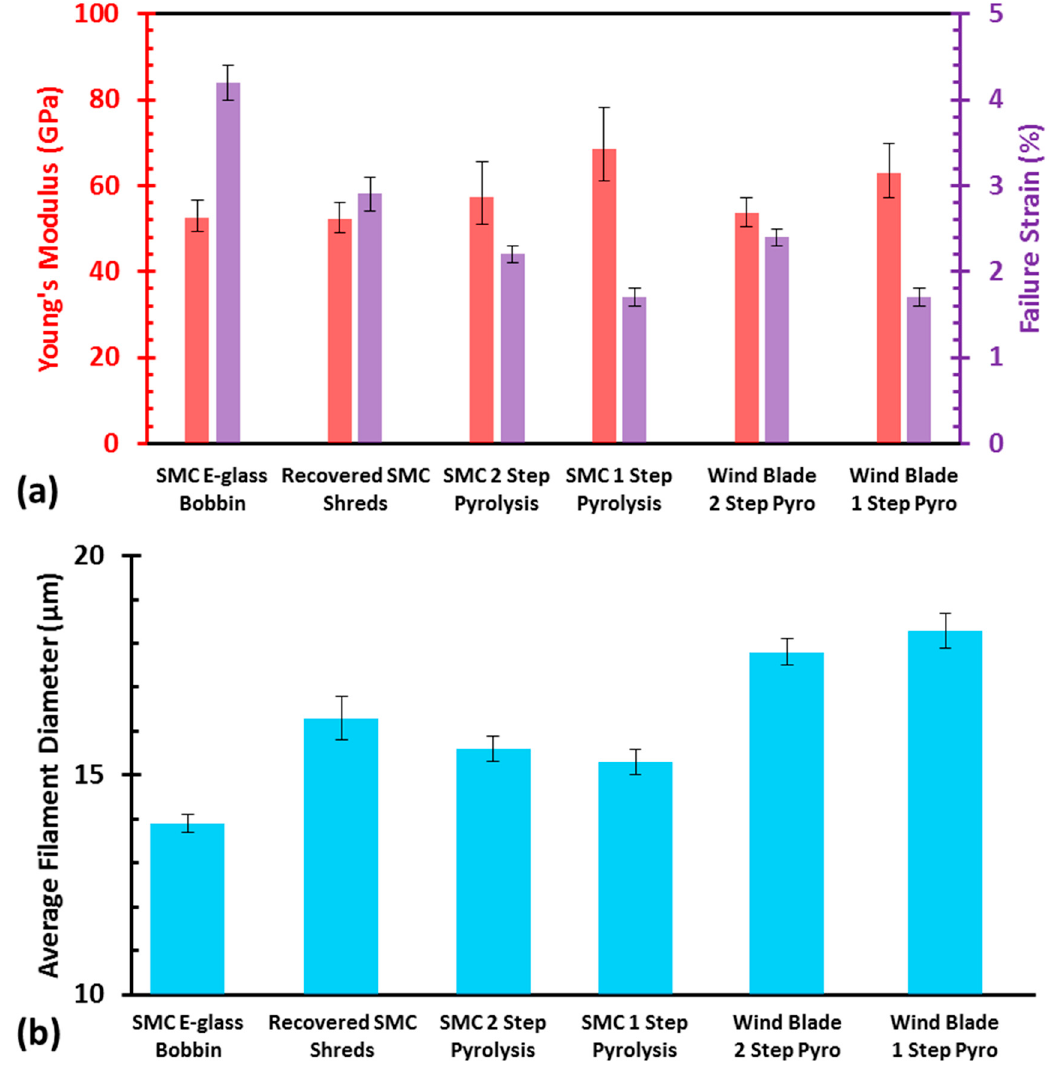
Figure 5. Average individual filament data ± standard error: ( a ) left / red columns representing Young’s modulus and right / purple columns representing failure strain for each tested condition, ( b ) average individual filament diameter.